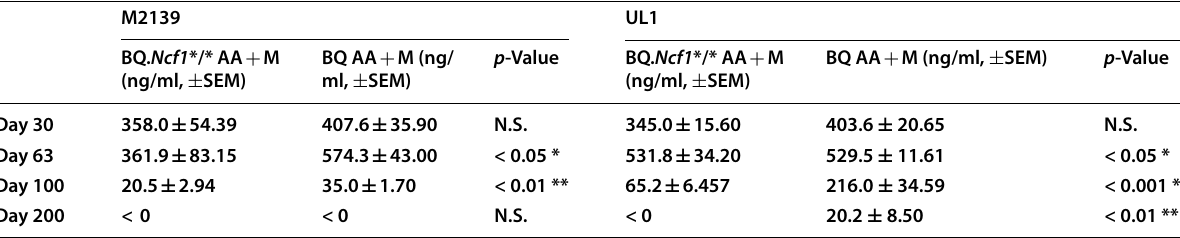
Notes: 1. M2139 concentration was calculated based on anti-GFS-4 antibody standard curve; 2. UL1 concentration was determined based on anti-GFS-10 antibody standard